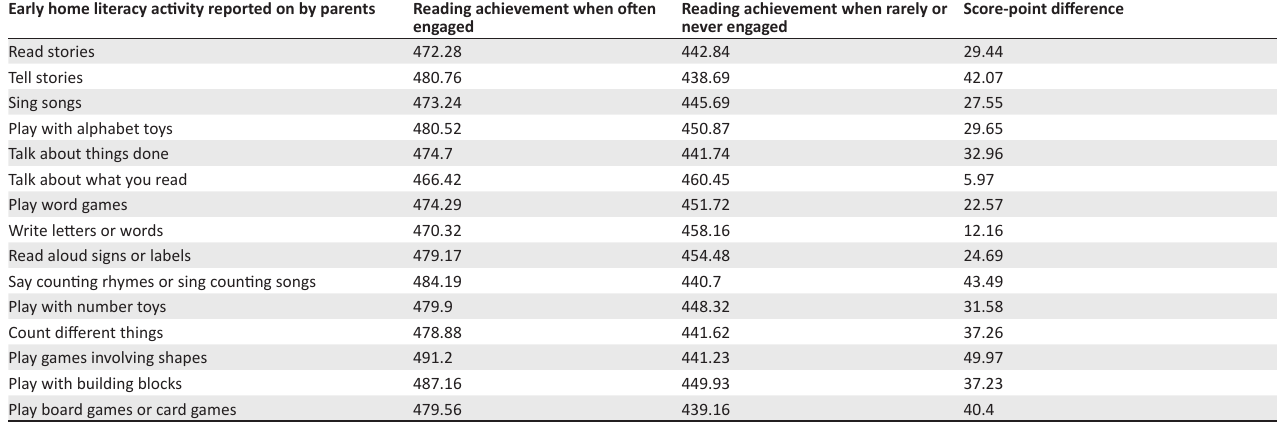
TABLE 2: Score-point differences based on frequency of early home literacy activities. Early home literacy activity reported on by